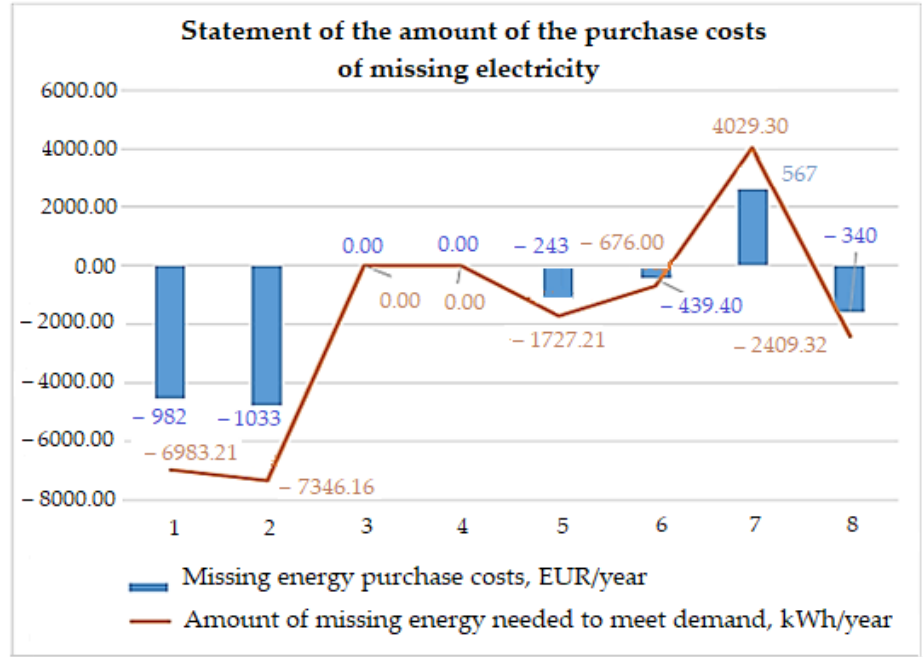
Figure 4. Summary of the quantity and costs of purchasing the missing electricity during the year: (1) 11.6 kW air-to-water heat pump; (2) ground source heat pump 12.5 kW; (3) 11.6 kW air-to-water heat pump + 8.4 kWp monocrystalline photovoltaic panels; (4) induction boiler 21 kW + 28.7 kWp monocrystalline photovoltaic panels; (5) 11.6 kW air-to-water heat pump + 2.2 kW wind turbine with a horizontal axis of rotation; (6) 11.6 kW air-to-water heat pump + 2 kW wind turbine with a vertical axis of rotation; (7) induction boiler 21 kW + wind turbine with a horizontal axis of rotation of 7.5 kW; (8) induction boiler 21 kW + wind turbine with a vertical axis of rotation 6 kW. Source: own